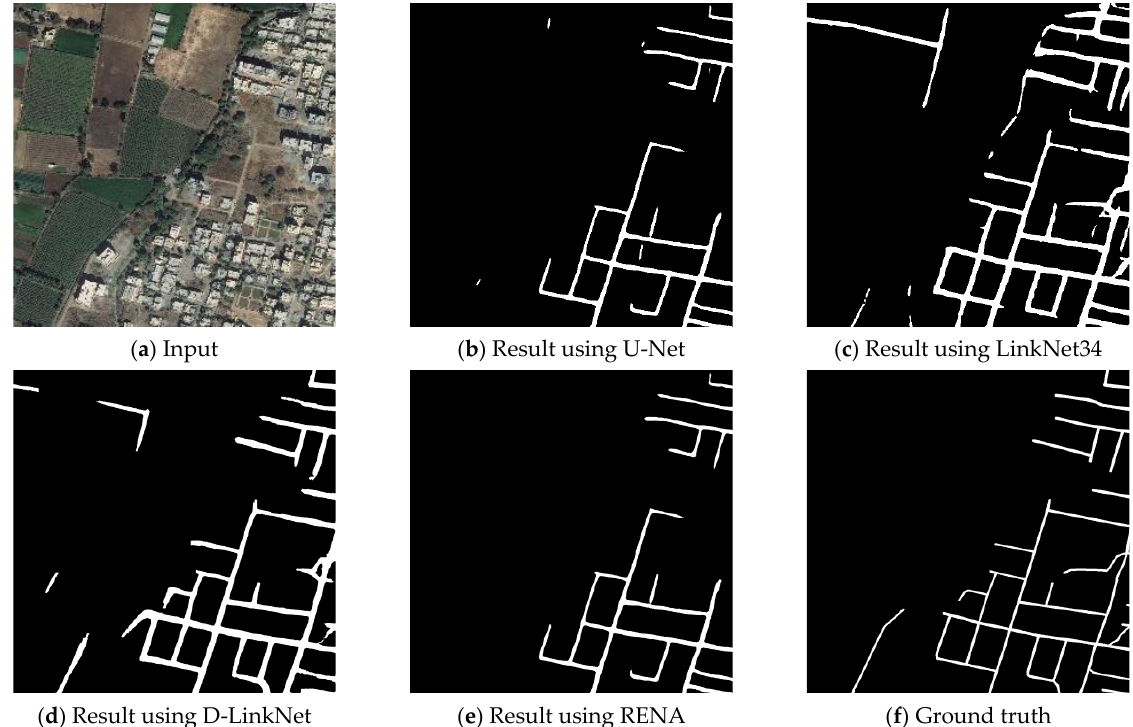
Figure 7. Visual evaluation results of the second group of dense road networks.